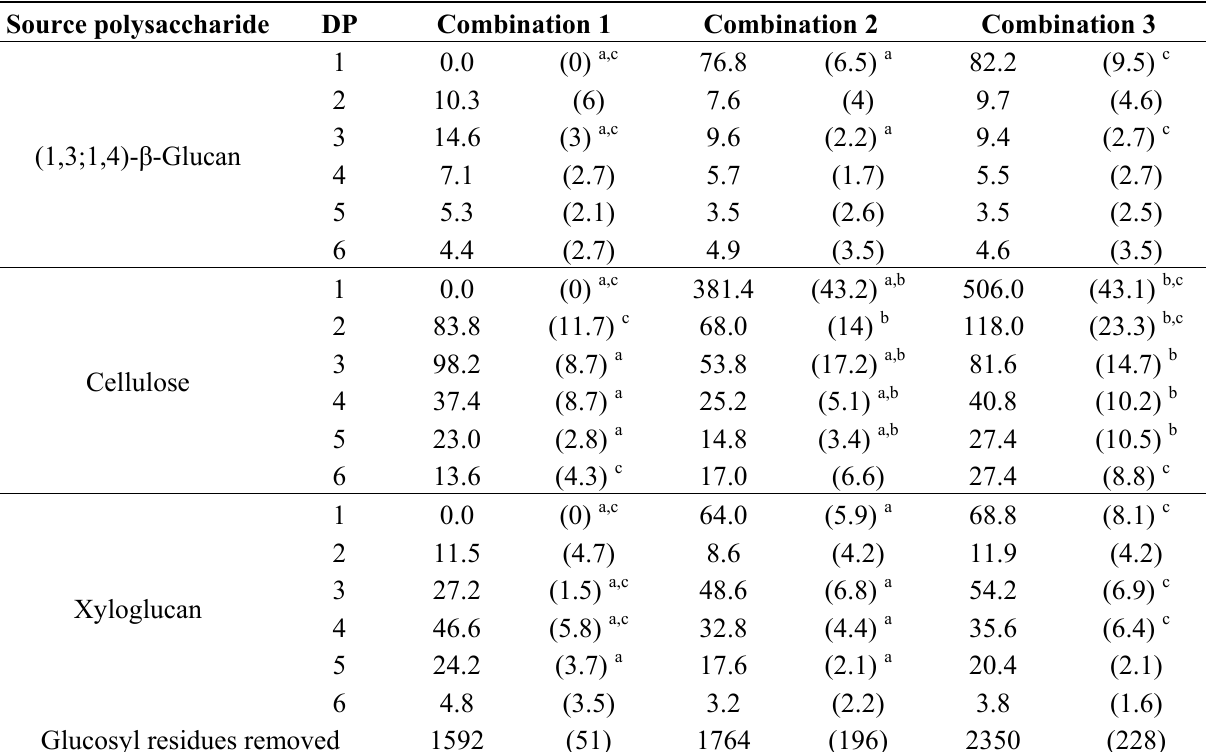
Table 1. Glucosyl-containing oligosaccharide breakdown products predicted by simulations of degradation of the mesophyll primary plant cell wall by three different enzyme combinations. Values are means and standard deviation (in parentheses) for the number of glucoses and glucosyl-containing oligosaccharides from the five simulation runs for each enzyme combination. The number of branches on xyloglucan oligosaccharides and the number of 1,3-linkages in (1,3;1,4)- β -glucan oligosaccharides has been omitted, although detailed in simulation output. DP: degree of polymerisation; Combination 1:40 Cel51A (endoglucanase) enzymes; Combination 2:20 Cel51A (endoglucanase) and 20 Cel9D (exoglucanase) enzymes; Combination 3:20 Cel51A (endoglucanase), 20 Cel9D (exoglucanase) and 20 endoxylanase 1 (endoxylanase with α -arabinofuranosidase activity) enzymes. The same superscripted letter appearing to the right of any two entries in a row indicates that the values are significantly different at the 5%